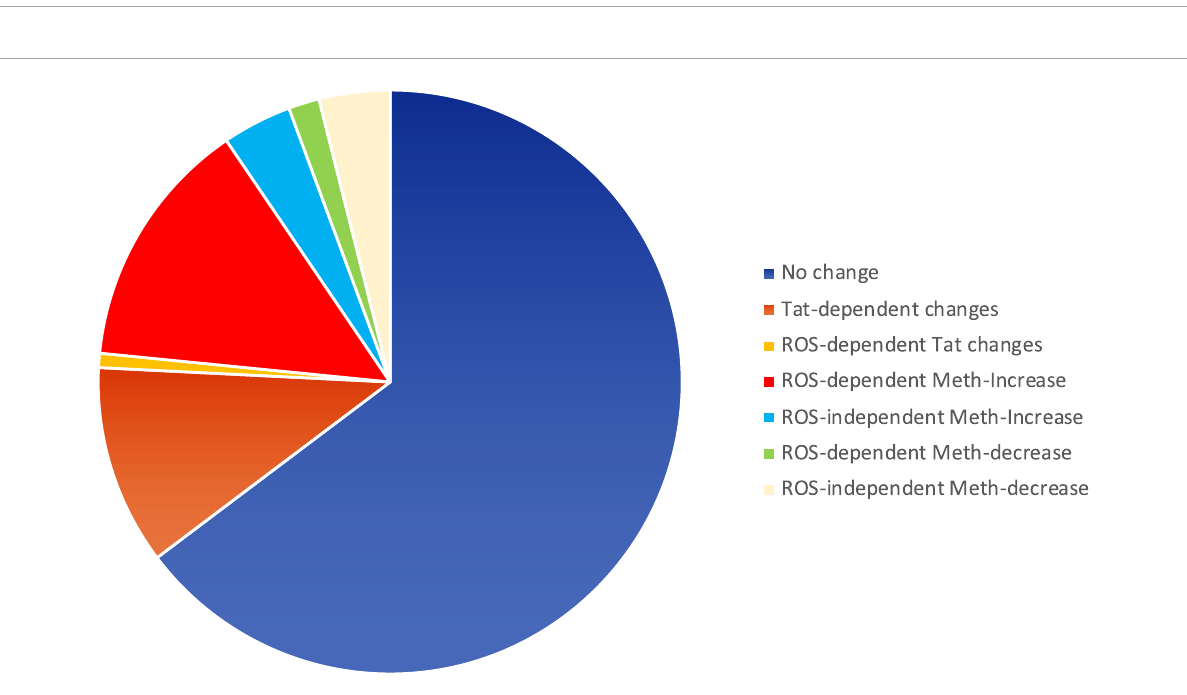
FIGURE4 Pie chart showing the relative impact of Meth and Tat on RNAPol recruitment to gene promoters in macrophages and the effects of ROS. RNAPol peak values from ChIP were obtained in THP1 cells treated with Meth (60 uM) or Tat (10 ng/ml) for 15 min, in the presence or absence of NAC (1